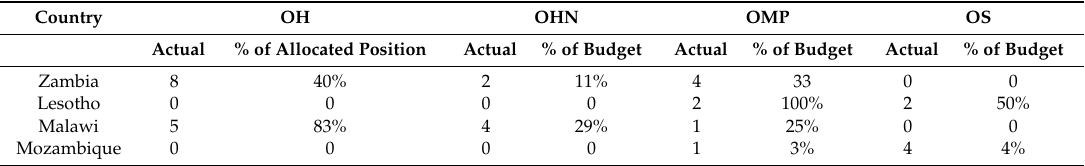
Table 2. Number of OH experts per each country against the required